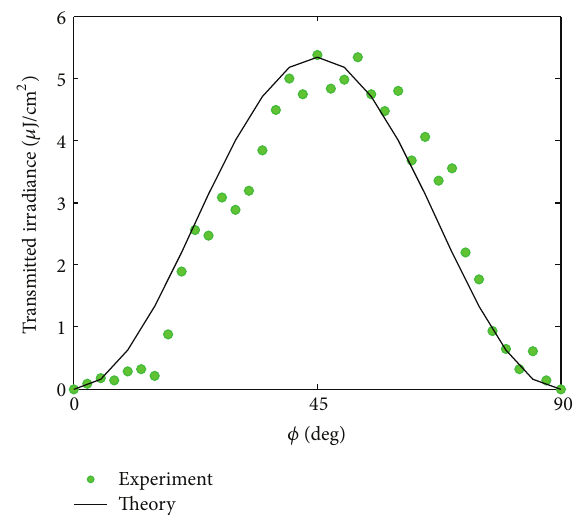
Figure 6: Transmitted irradiance of the probe beam versus angle 𝜙 between planes of polarization of the incident